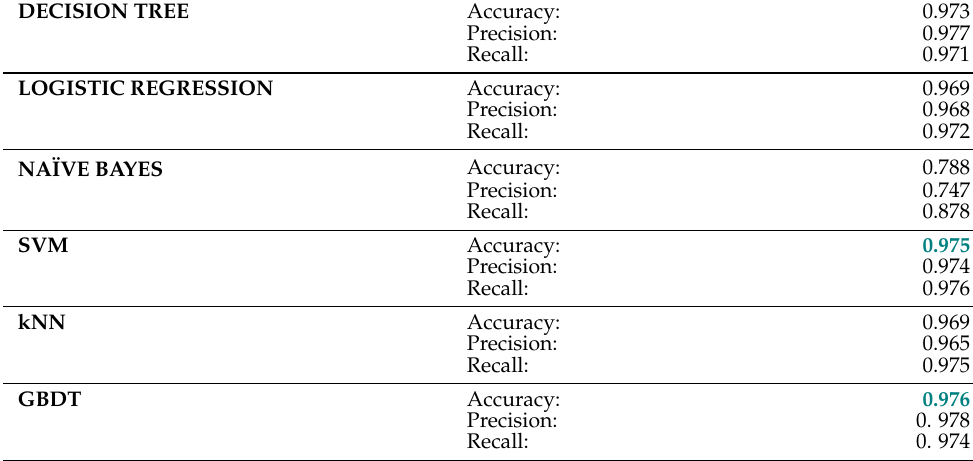
Table 7. Factor Model Validation